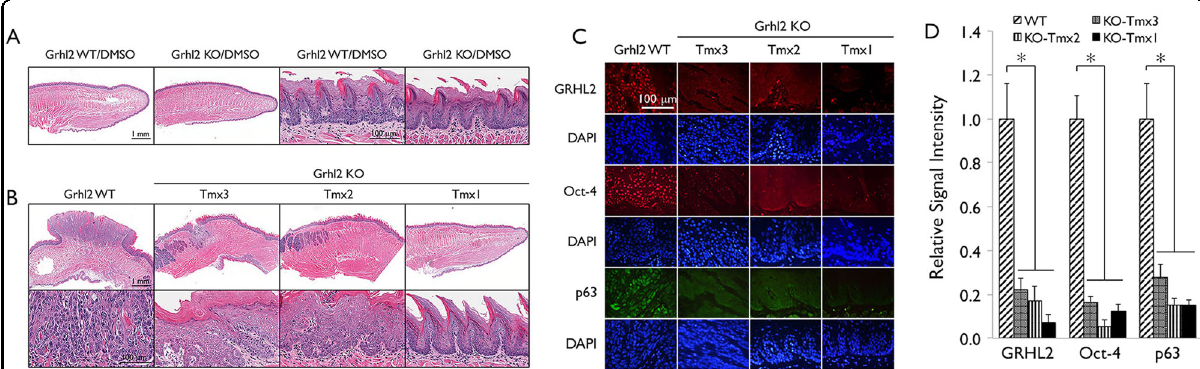
Fig. 4 Grhl2 KO suppresses 4-NQO-induced histopathology in tongue tumors. a Gross morphology of tongues from Grhl2 WT and KO mice exposed to DMSO were shown without altered morphology or histology of the tongue epithelium. b In Grhl2 WT mice treated with 4-NQO, polypoid masses and widespread dysplastic changes are present. A higher-power view shows that the mass is composed of proliferating malignant epithelial islands and has invaded the underlying muscle layer. Keratin formation and a high mitotic index are obvious. Tongue sections from Grhl2 KO Tmx1 mice show slightly thickened surface epithelium on the tongue. The differentiation is mostly within normal limits. Tongue sections from Grhl2 KO Tmx2 mice show epithelial hyperplasia with multifocal mild to moderate epithelial dysplasia. Tongue sections from Grhl2 KO Tmx3 mice show extensive epithelial hyperplasia with widespread dysplastic changes and formation of polypoid masses. Invasion was not noted in any of the Grhl2 KO mice examined. c IHC was performed with tongue tissues from Grhl2 WT and KO (Tmx1, Tmx2, and Tmx3) mice after 4-NQO exposure for GRHL2, Oct- 4, and p63. Nuclei were stained with DAPI. d IFS signals were quantitated and plotted with the mean values for Grhl2 WT and different KO mouse groups after exposure to 4-NQO. Bar indicates mean/SD. * P o 0.05, statistical signi fi cance, compared with WT